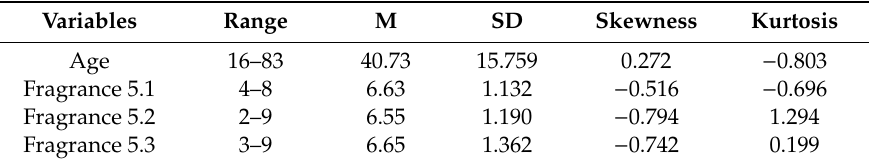
Table 5. Descriptive and univariate normality analysis.